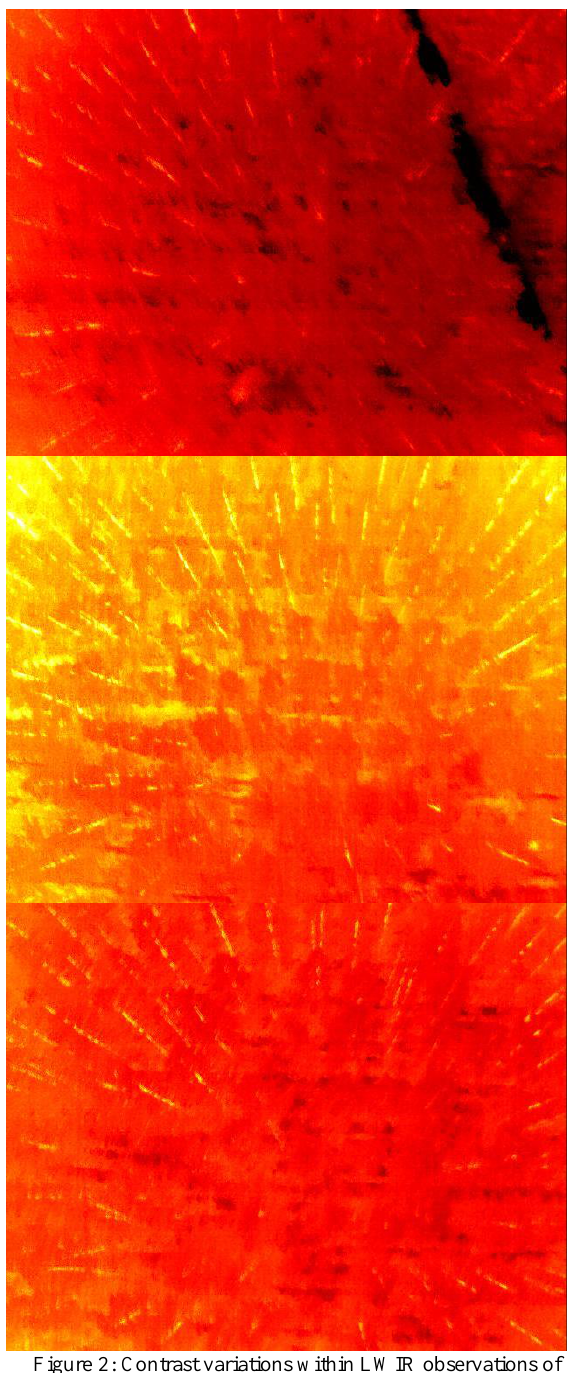
Figure 2: Contrast variations within LWIR observations